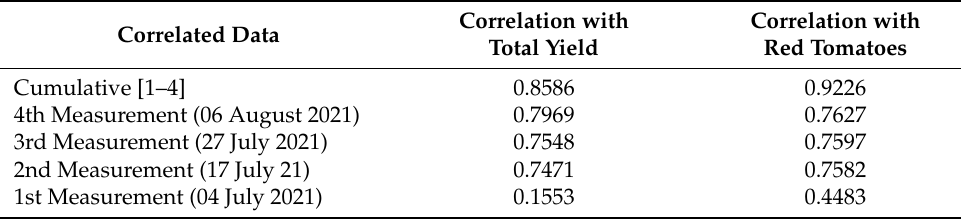
Table 14. The Pearson correlation values between the quantile classification of the NDVI data and the ground truth samples collected in early August.